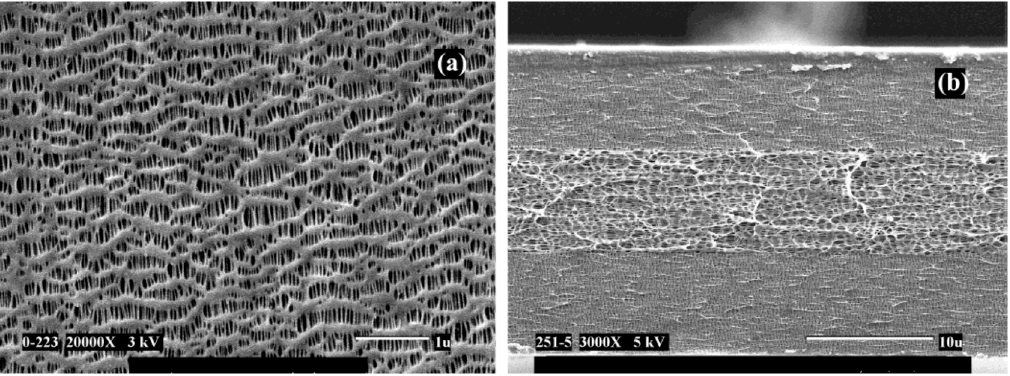
Figure 16. SEM images of Celgard 2325 (PP/PE/PP) separator used in lithium-ion batteries: ( a ) surface SEM and ( b ) cross-section SEM images. Adapted with permission from [161], © American Chemical Society, 2004.